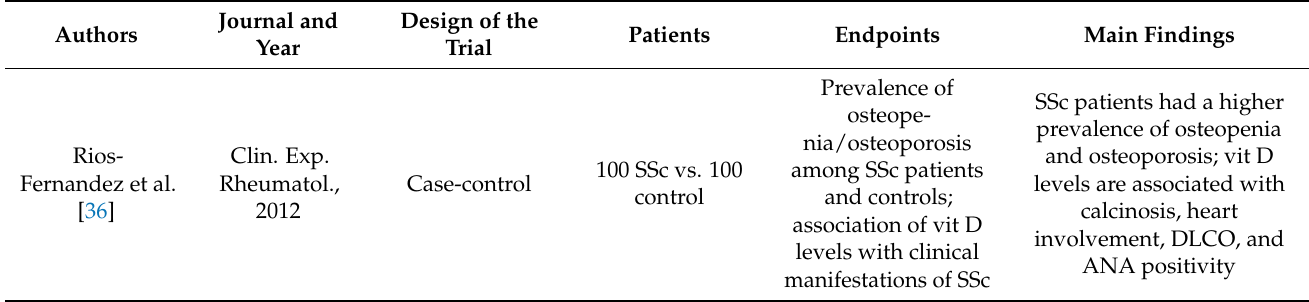
Table 2. Summary of the clinical study selected. Abbreviations: SSc, systemic sclerosis; vit D, vitamin D; DLCO, diffusing lung capacity of the lung for carbon monoxide; ANA, antinuclear antibodies; BMD, bone mineral density; BMI, body mass index; dcSSc, diffuse cutaneous SSc; lcSSc, limited cutaneous SSc; VDR, vitamin D receptors; CT, computed tomography; DUs, digital ulcers; ET-1, endothelin 1; FGF-23, Fibroblast growth factor